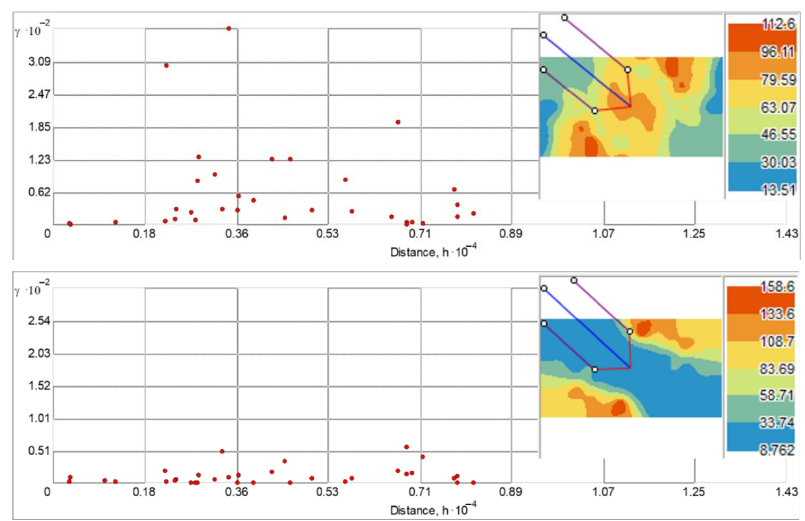
Figure 8. The semivariogram cloud and anisotropic model based on the semivariogram maps of collected data in the vegetation season ( top ) and heating season ( bottom ).